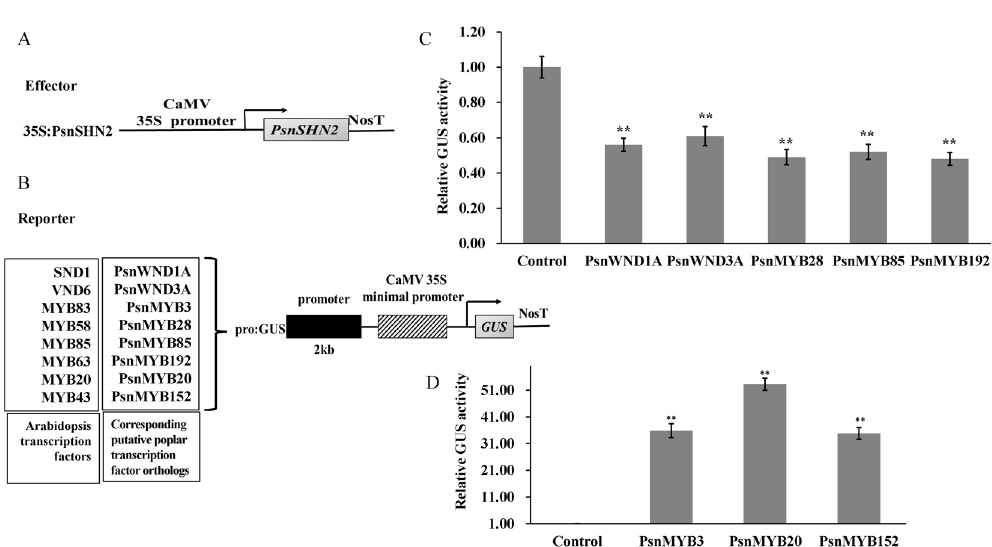
Figure 6. Expression analysis the TF genes and secondary wall biosynthesis genes in PsnSHN2 transgenic lines. Secondary wall biosynthesis genes for cellulose ( CESA4 , CESA7 , and CESA8 ), hemicellulose ( IRX8 , IRX9 , and IRX10 ), and lignin ( PAL1 , PAL4 , C3H , C4H , 4CL1 , 4CL2 , 4CL3 , CCR , HCT , COMT , CCoAOMT , CAD6 , and CAD 9). MYB20 , MYB43 , MYB69 , MYB58 , MYB63 , MYB85 , MYB83 , VND6, and SND1 are known TFs that control the secondary wall formation. Error bars represent SD of three biological replicates. Asterisks indicate levels of significance ( t test; * P < 0.05, ** P < 0.01).